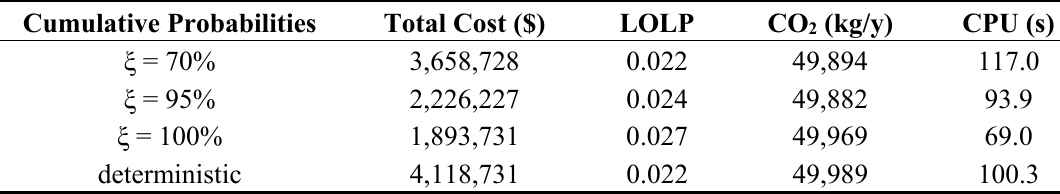
Table 8. Result comparison between different cumulative probabilities.